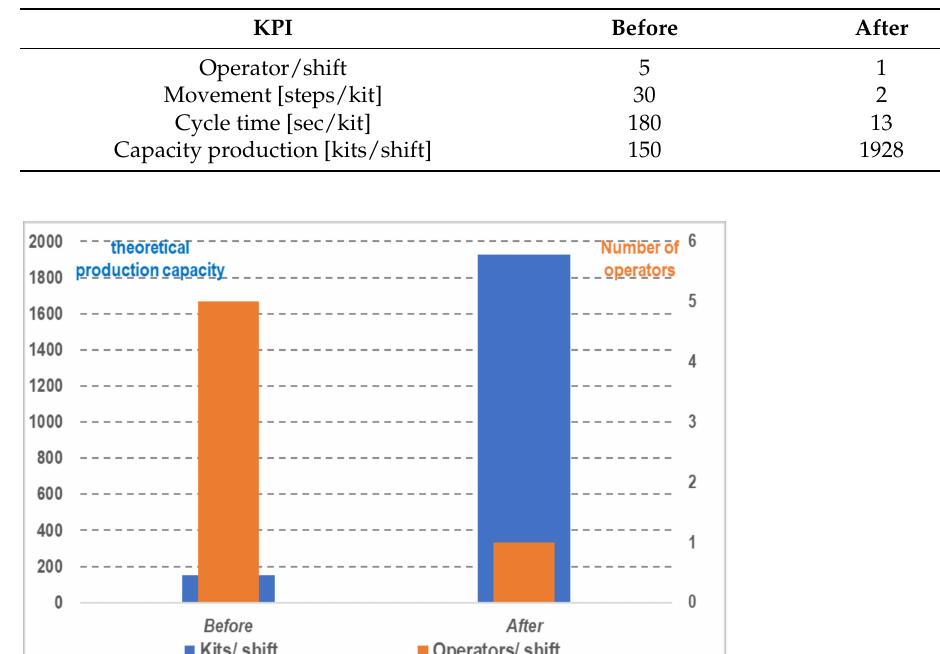
Table 1. KPI system evolution.